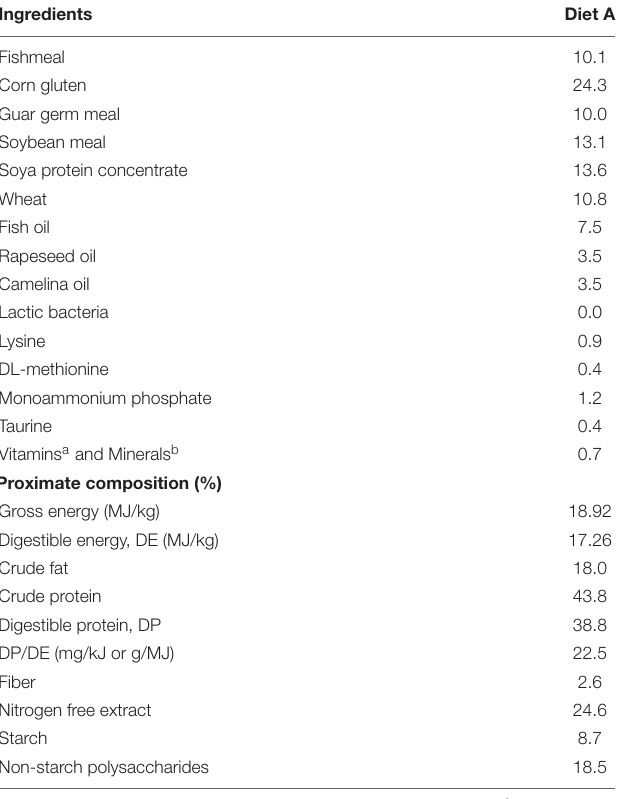
TABLE 1 | Ingredients and chemical composition (%) of control diet (Diet A) used in the trial.